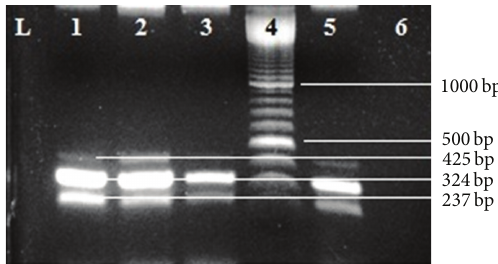
Figure 1: Multiplex PCR (mPCR) targeting fim2 (425 bp), alc (324 bp), and fla (237 bp) gene. Lane 1: positive control ( B. bron- chiseptica snap-chilled supernatant DNA); Lanes 2, 3, and 5: field sample (snap chilled supernatant); Lane 4: 100bp ladder; Lane 6: negative